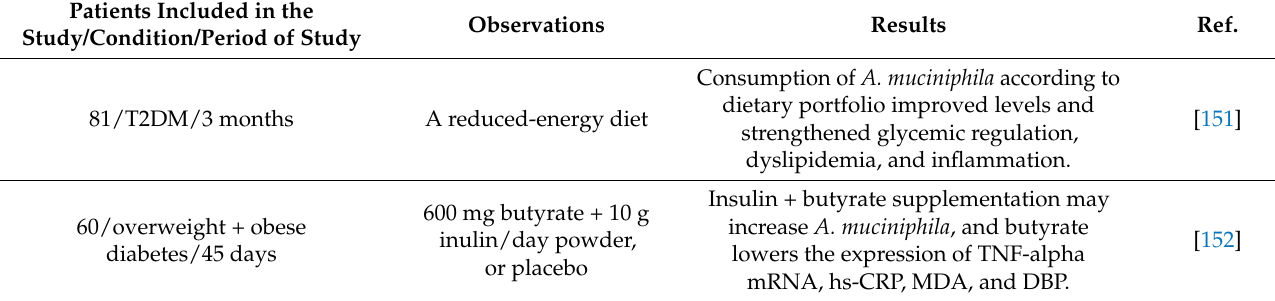
Table 2. Clinical studies of obesity implying A. muciniphila and its associated biomarkers. Patients Included in the Study/Condition/Period of Study